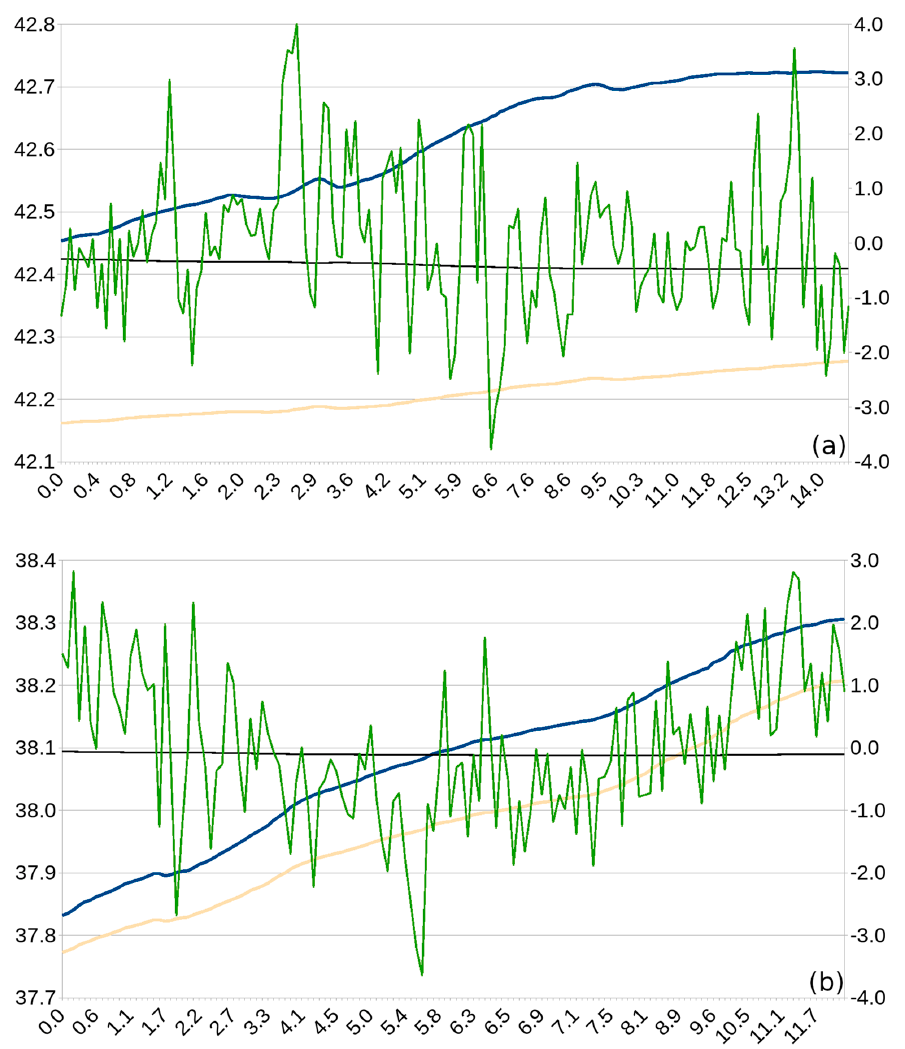
Figure 10. Geoid heights from EGM96 (yellow) and EGM2008 (blue), geoid heights difference between two models (grey line) and height difference between Copernicus DEM and AW3D30 (green line) for the ( a ) Northern and ( b ) Central traverse. (left y ‐ axis for geoid heights in m/right y ‐ axis for height differences in m/ x ‐ axis for distance in km).